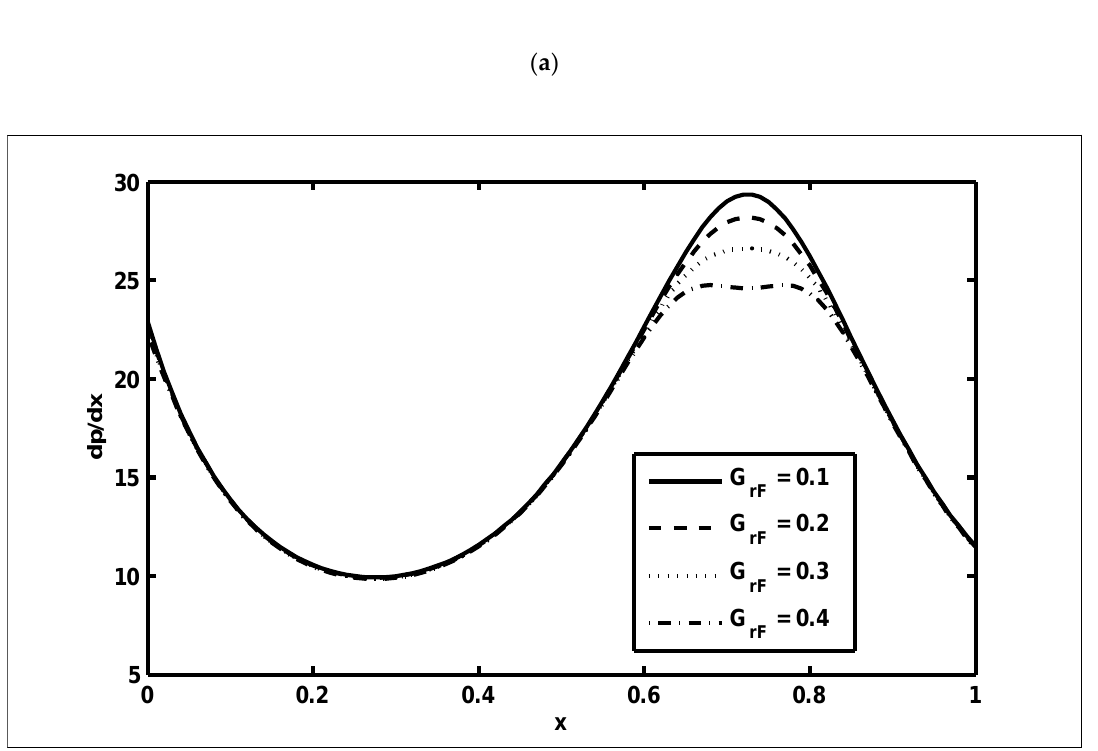
Figure 3. The pressure gradient ( dp / dx ) against the axial distance ( x ): ( a ) N CT = 0.3, N TC = 0.7, G rc = 0.4, G rF = 0.1, G rt = 0.5, N t = 0.7, M = 4, φ = π ( b ) N CT = 0.3, N TC = 0.7, G rc = 0.4, N b = 0.1, G rt = 0.5, N t = 0.7, M = 4, φ = π β = 0.4, m = 0.4, Q = −